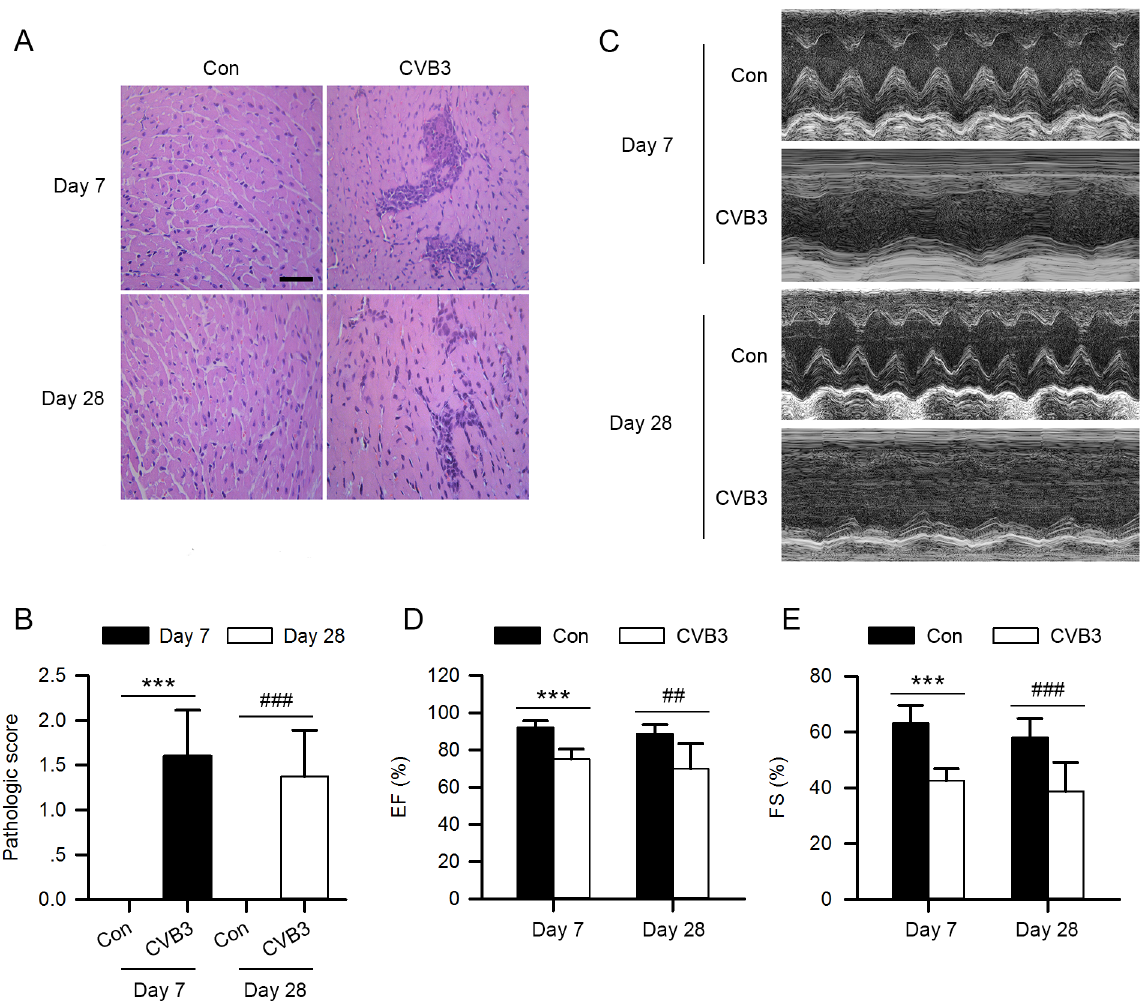
Fig 1. The establishment of CVB3-induced VMC model. 4-week-old male C57BL/6 mice were injected intraperitoneally with 1000 TCID 50 of CVB3 virus or an equal amount of DMEM on day 0. (A) Representative HE staining of paraffin sections of heart tissues from VMC mice and control mice on both day 7 and day 28 after virus injection. Scale bar: 50 μ m. (B) The pathologic score of myocarditis was assessed according to the mononuclear infiltration foci and myocardial necrosis. (C) Representative M-mode echocardiographic images of VMC mice and control mice on day 7 and day 28 post-infection. (D, E) Left ventricular ejection fraction (LVEF) and left ventricular fractional shortening (LVFS) from the echocardiographic data for both day 7 and day 28 post-infection. (Con: control group; CVB3: coxsackievirus B3 group; Con: n = 10; CVB3: n = 10; (cid:3)(cid:3)(cid:3) P < 0.001 vs . Con-day 7; ##P < 0.01 vs . Con-day 28; ###P < 0.001 vs . Con-day